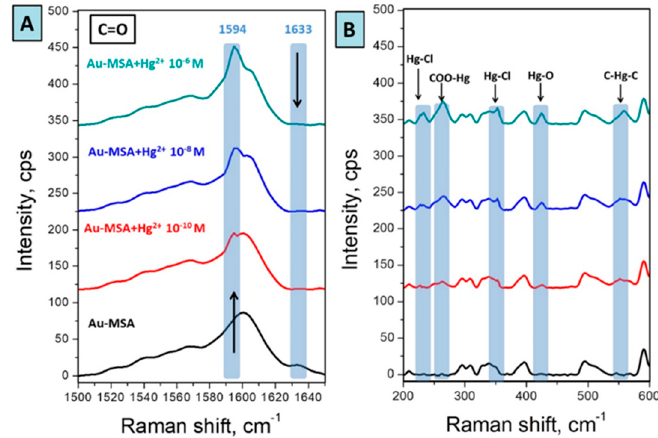
Figure 6. ( A ) Dependence of C=O peak shift in the dependence of Hg 2+ concentration; ( B ) Enlarged area (200–600 cm − 1 ) of SERS spectra from Figure 4, indicating the formation of a complex of MSA with Hg 2+.